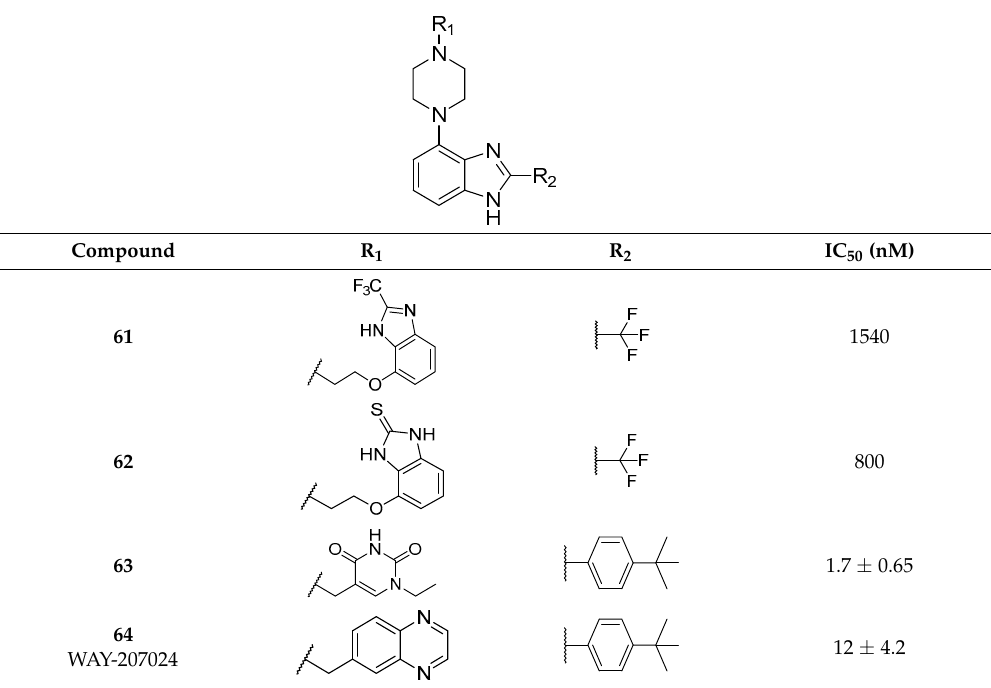
Table 11. Piperazine-benzimidazole derivatives and their binding affinity at human GnRH-R.